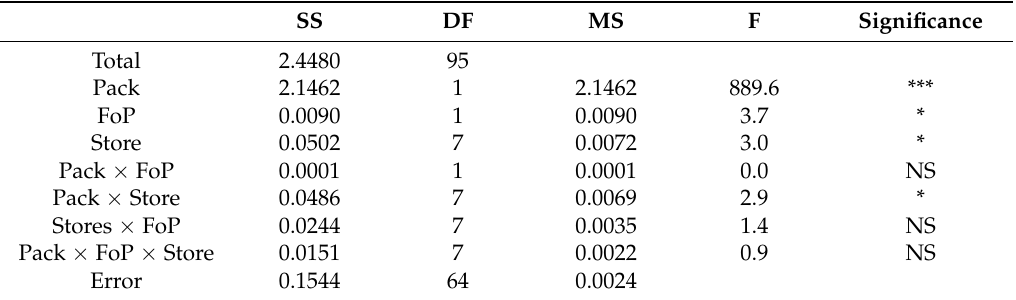
Table 4. Analysis of variance Christchurch, stores as third independent